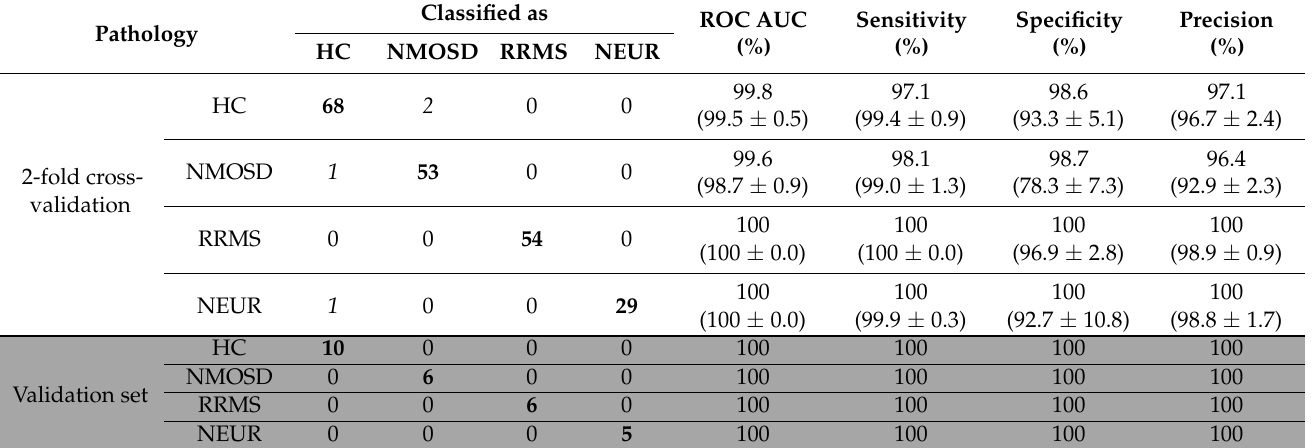
Table 1. Performances (confusion matrix, receiver operating characteristic curve (ROC AUC), sensi- tivity, specificity, and precision) of the random forest model based on second derivatives of the FTIR spectra of serum samples discriminating HC, NMOSD, RRMS and NEUR. The first row concerns two-fold cross-validation on the training set (70 HC, 54 NMOSD, 54 RRMS and 30 NEUR). The values in parentheses correspond to a ten-iteration internal validation of the model (see Materials and Methods for details). The grey rows record the performances on the test set (10 HC, 6 NMOSD, 6 RRMS and 5 NEUR). True positives are in bold and false negatives/false positives are in italics.